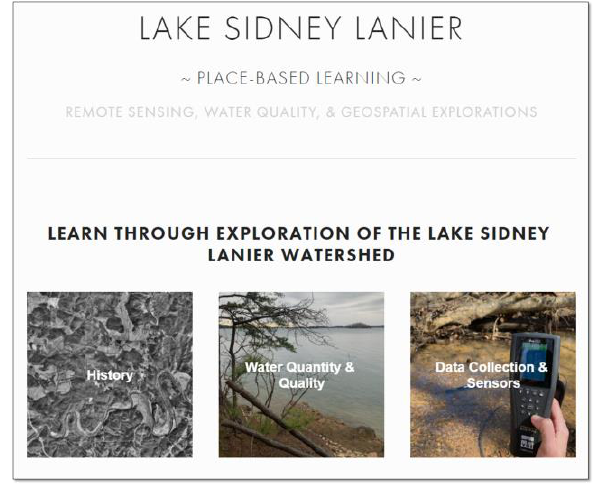
Figure 1. Website with interdisciplinary open education place- based course materials.